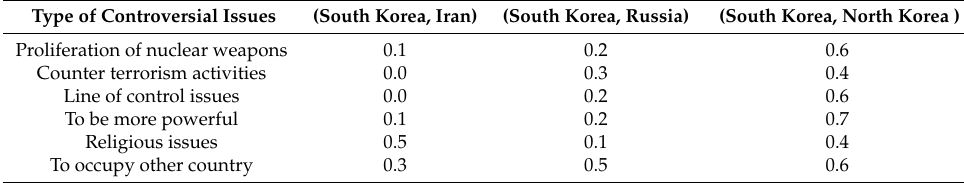
Table 9. Fuzzy set of controversial issues between South Korea and other countries.